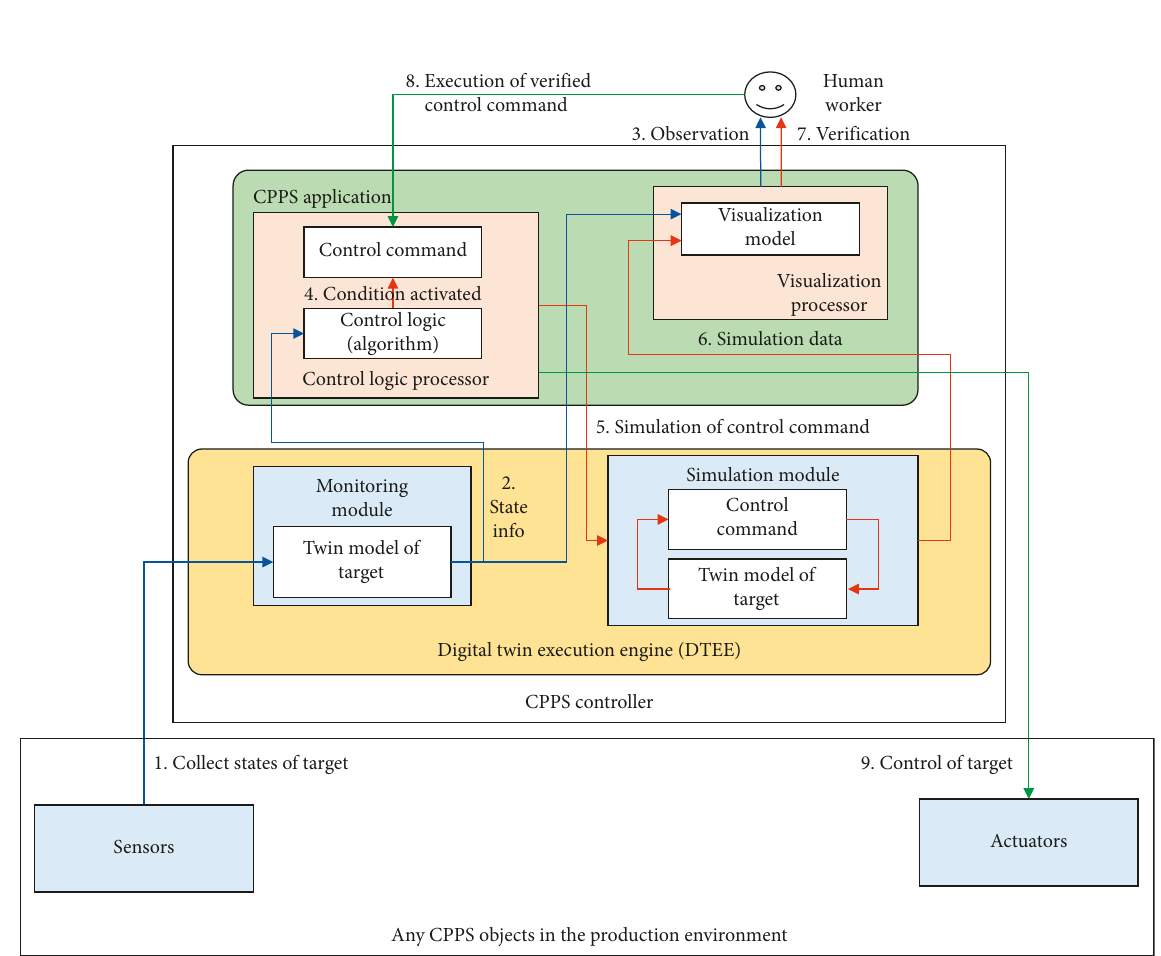
Figure 7: A DigTwinOps framework design.